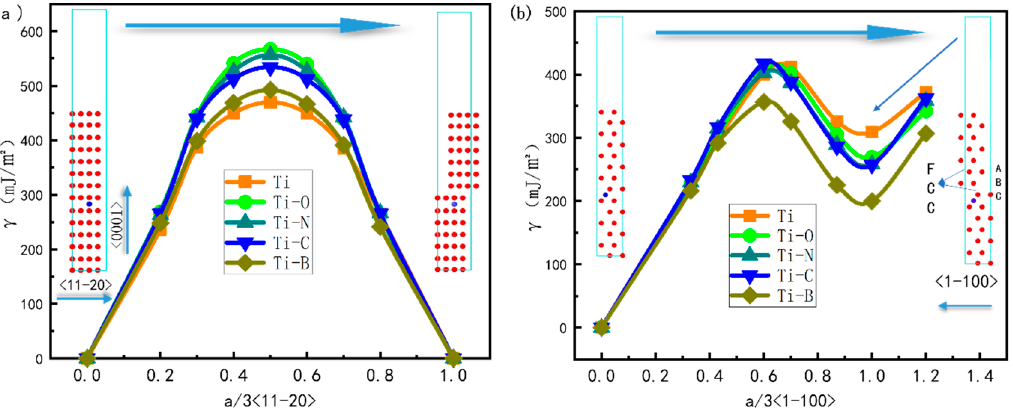
Figure 9. ( a ) Generalized layer fault energy of α -Ti along direction <1120>; ( b ) generalized layer fault energy of α -Ti along direction <11